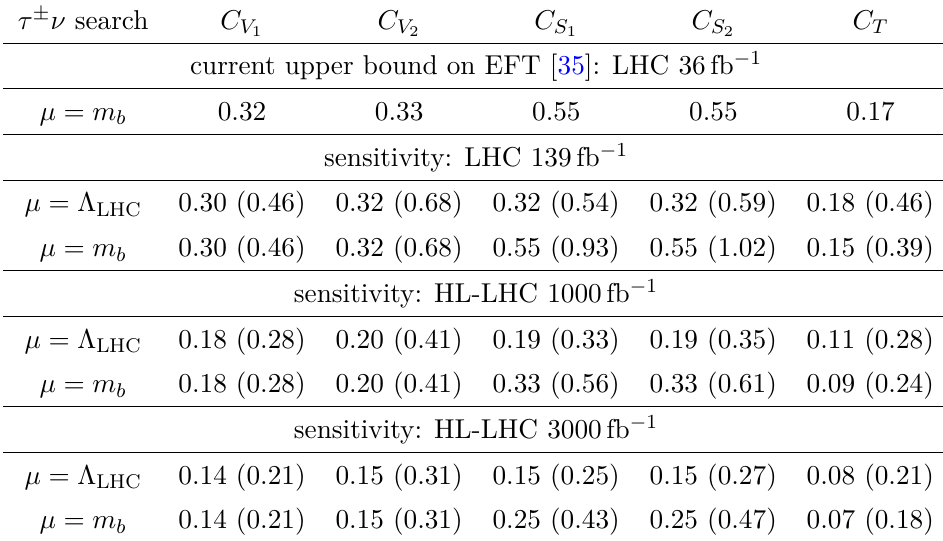
Table 5 . Expected sensitivities to the absolute value of the WCs in the single-operator scenarios. They are evaluated at the scale of µ = Λ LHC and m b based on cut a (the τ ± ν search). The number without (inside) the parenthesis correspond to the EFT limit ( M LQ = 1 . 5 TeV ). Also shown are the